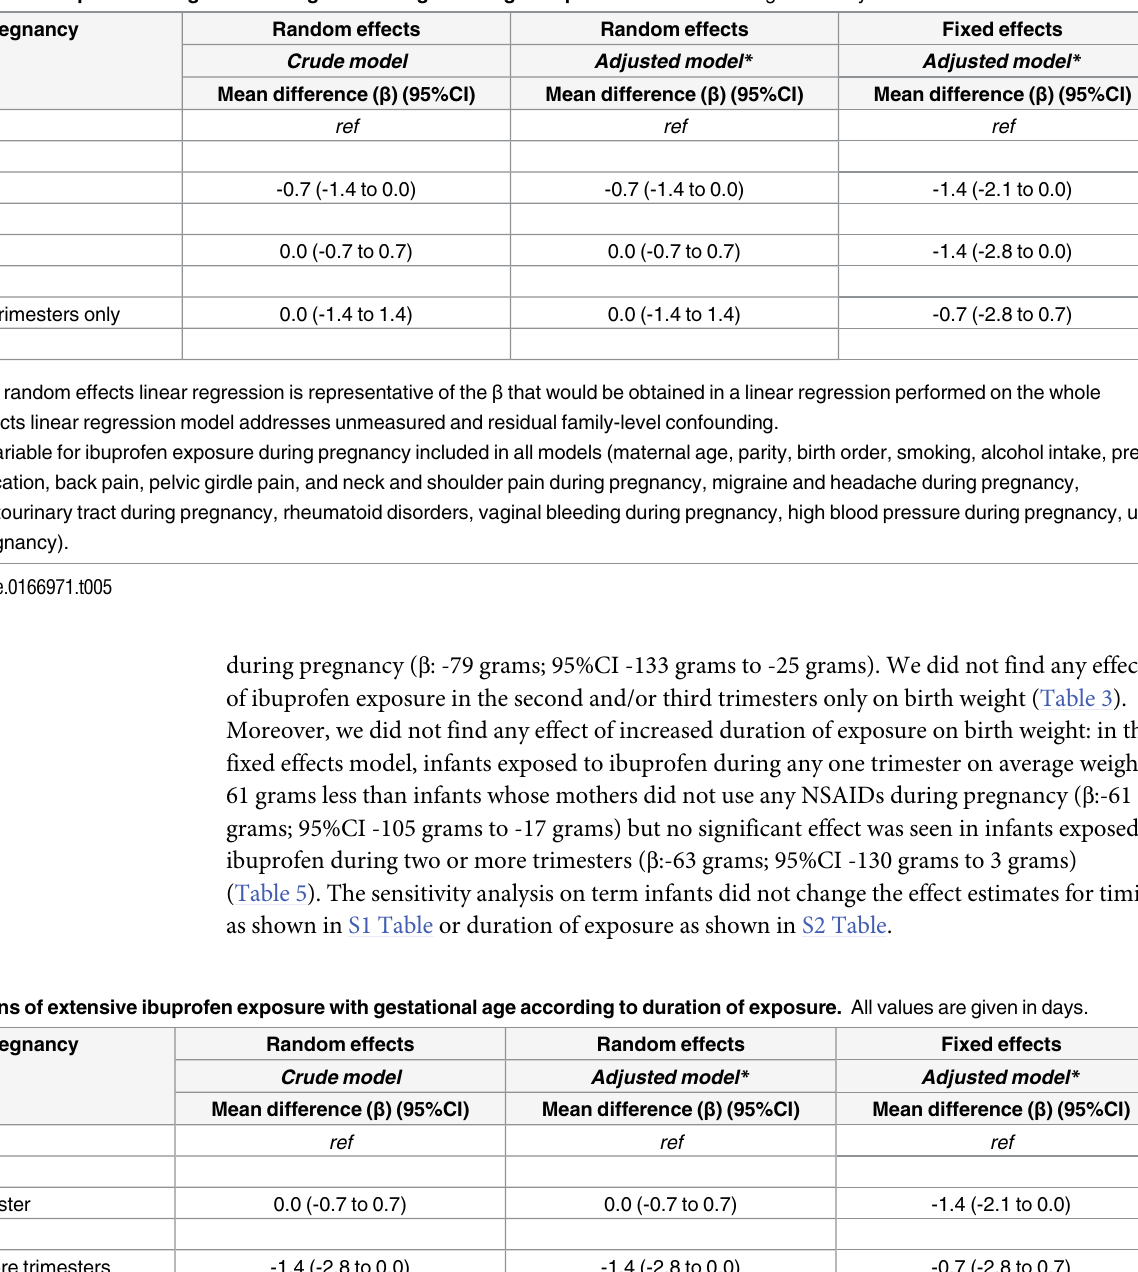
Table 6. Associations of extensive ibuprofen exposure with gestational age according to duration of exposure. All values are given in days. Exposure during